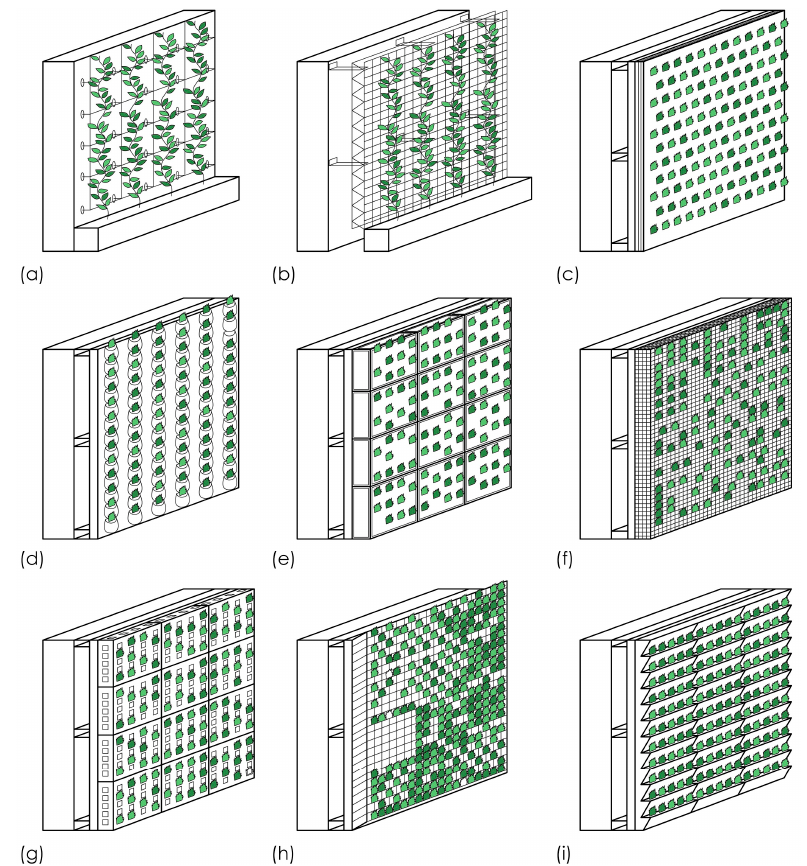
Figure 5. Diversity of living wall typologies [26]. ( a ) Indirect green facade with a two-dimensional trellis, ( b ) indirect green facade with a three-dimensional trellis, ( c ) vegetated mat living wall system, ( d ) hanging pocket living wall system, ( e ) framed box modular living wall system, ( f ) wire cage modular living wall system, ( g ) perforated box modular living wall system, ( h ) slanted cell box modular living wall system, and ( i ) through